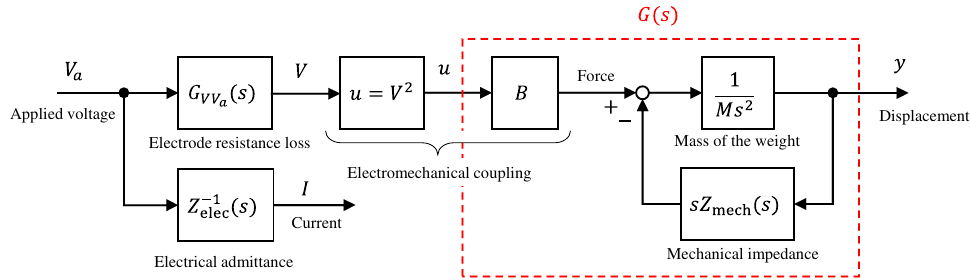
Figure 8. Block diagram of the overall model.